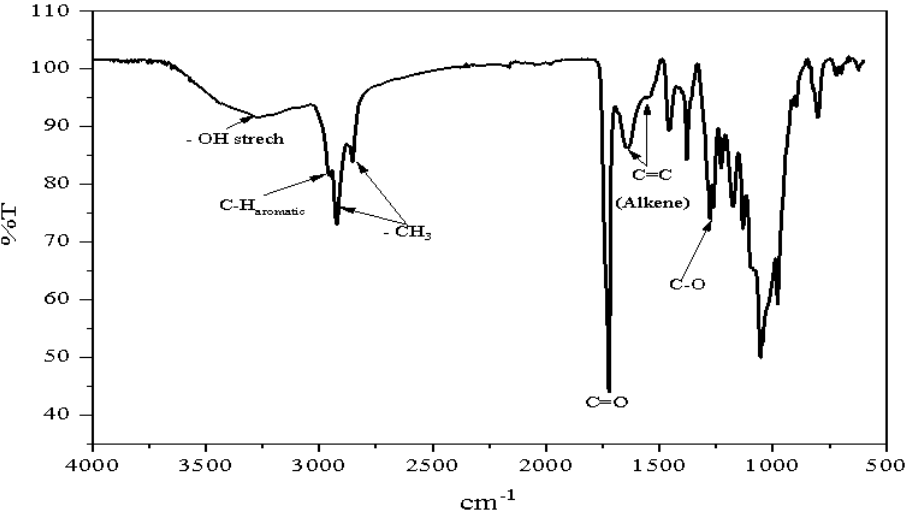
Figure 1. FT-IR spectrum of PHA produced Acinetobacter sp. strain AAAID-1.5 grown in MSM containing used transformer oil as carbon source.